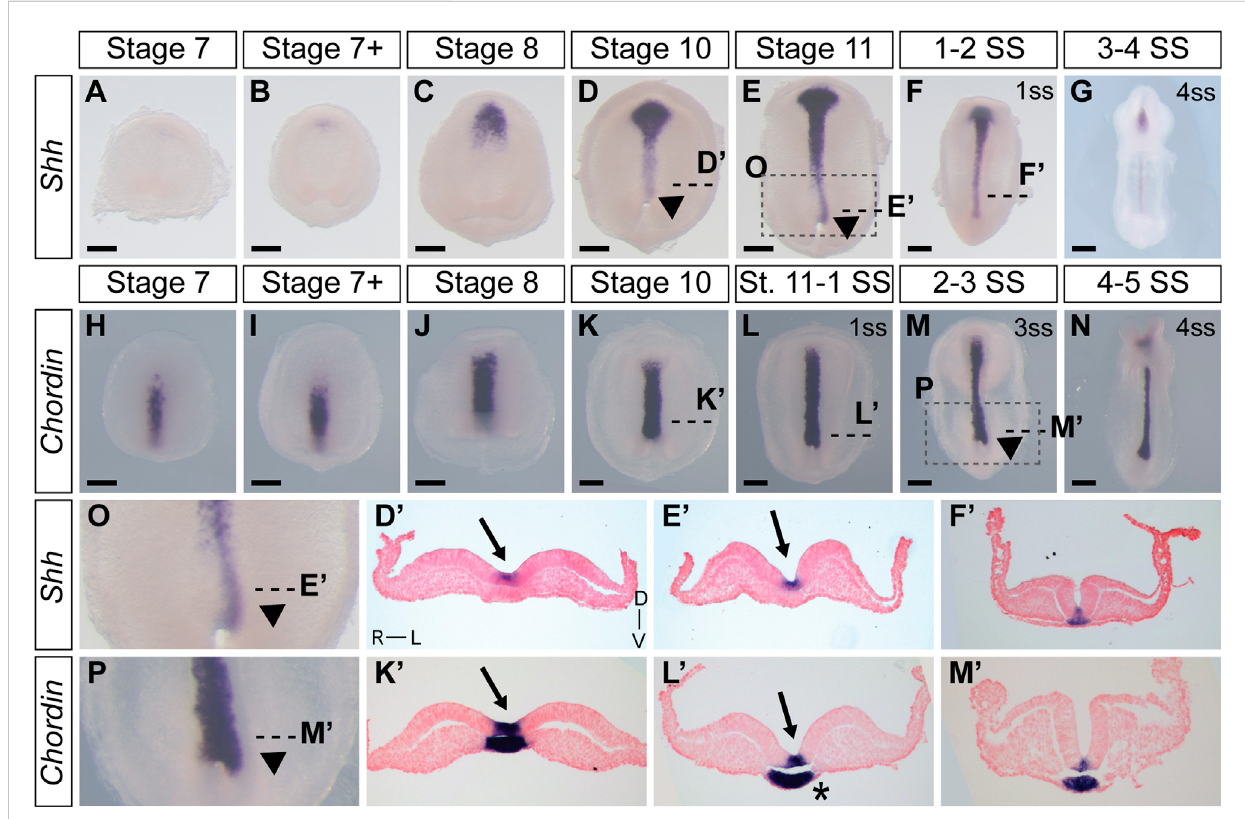
FIGURE 6 Expression of Shh and Chordin in veiled chameleons reveal tissue rearrangements and morphological changes in embryos. All embryos are presentedinventralview,unlessotherwisenoted.DorsalviewavailableinSupplementaryFigureS6. (A – G) WholemountRNA insitu hybridizationfor Shh expression. Arrowheads point to asymmetric patterning of the midline near the blastopore. (H – N) Whole mount RNA in situ hybridization for Chordin expression. (O, P) Enlarged areas of asymmetry, as indicated in (E, M) with a dashed box. (D 9 , E 9 , F 9 , K 9 , L 9 , M 9 ) Transverse sections of embryos from (A – N) ,asindicatedwithdashedlines.Sectionswerecounterstainedwithnuclearfastredforbettervisualization.Sectionorientationisasindicatedin (D 9 ) . Arrows point to the medial hinge point of the neural tube. Asterisk reveals asymmetry in notochordal plate. All scale bars are 200 μ